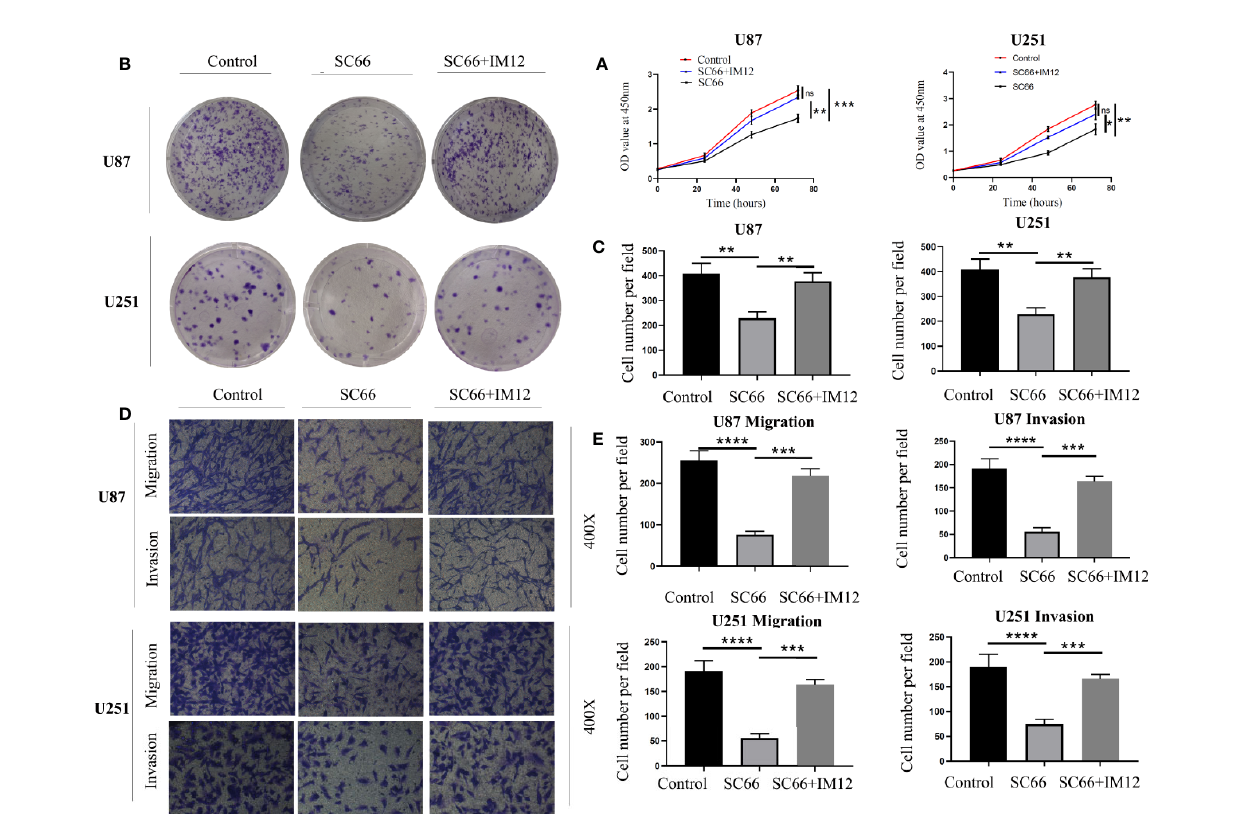
FIGURE 6 | Elevating b -catenin activity rescued SC66 inhibition ‐ mediated GBM cell proliferation and metastasis. (A – C) IM12 was used to enhance b -catenin signaling pathways. CCK 8 and Clone formation assays were performed to investigate the proliferation in U87 and U251 cells. (D, E) Transwell assay was performed to detect the migration and invasion in GBM cells. For at least three independent experiments. n.s., no signi fi cance; *P < 0.05, **P < 0.01, ***P < 0.001, ****P <